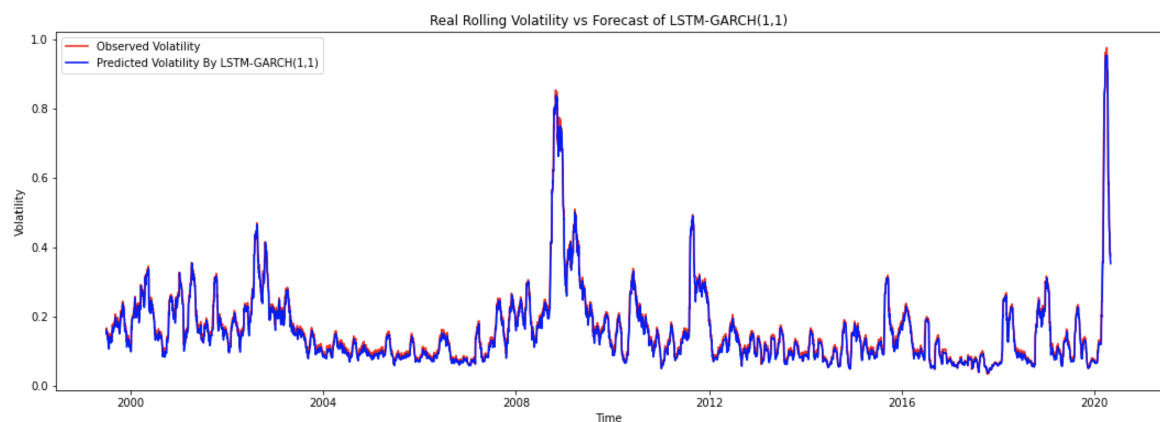
Figure 5. Observed volatility and predicted volatility by the hybrid algorithm for the S&P 500 index from January 2000 to March 2020 (source: authors’